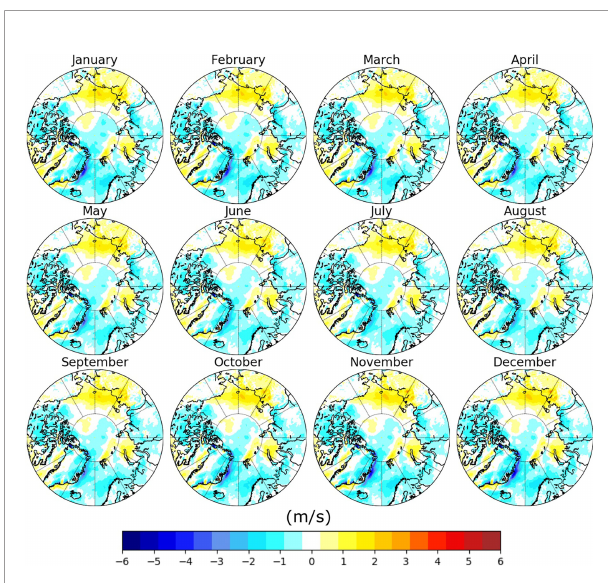
FIGURE 8 | U 100 10 (ms -1 ) for 1993 obtained with a POT analysis and a GPD distribution for the TS-EVA seasonal approach. Data obtained from the ERA5 dataset.